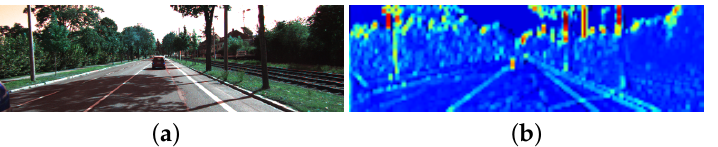
Figure 10. Test image on which layer wise explanations are presented.